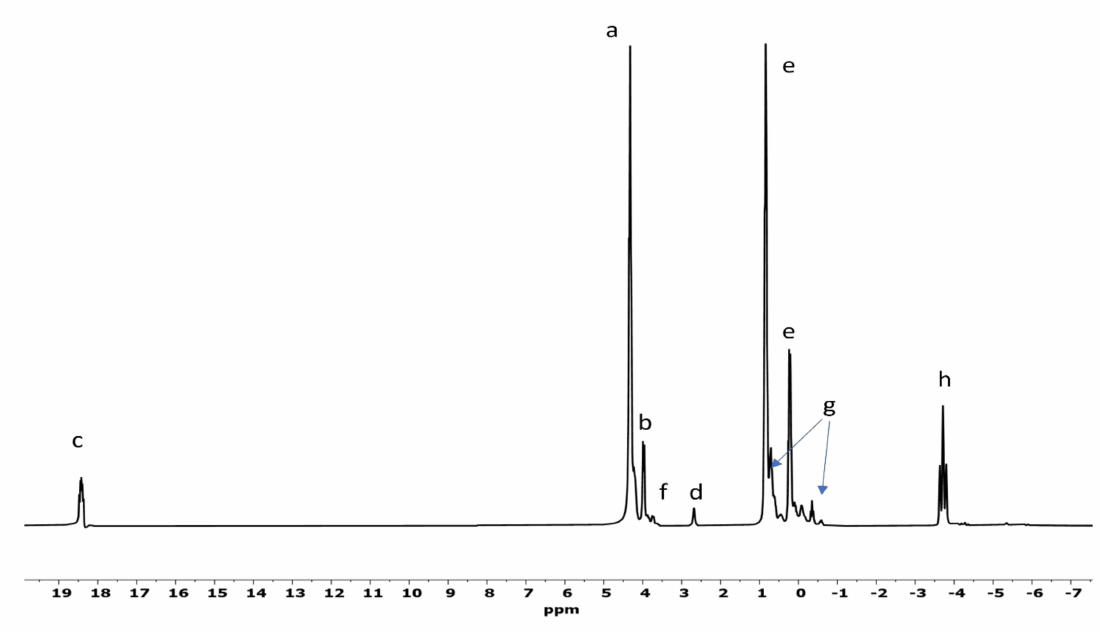
Figure 2. Formation of GP in the presence of basalt. Peak ‘g’ is also a plausible isomer of GP